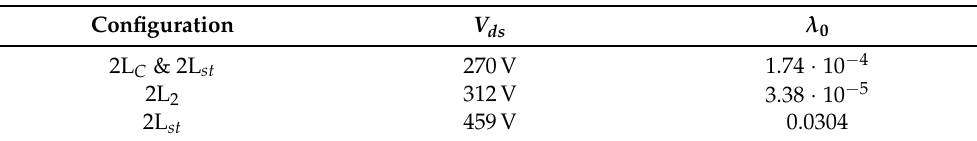
Table 2. Sea level FIT/cm 2 rates from the universal curve considering a semiconductor breakdown voltage of V bd